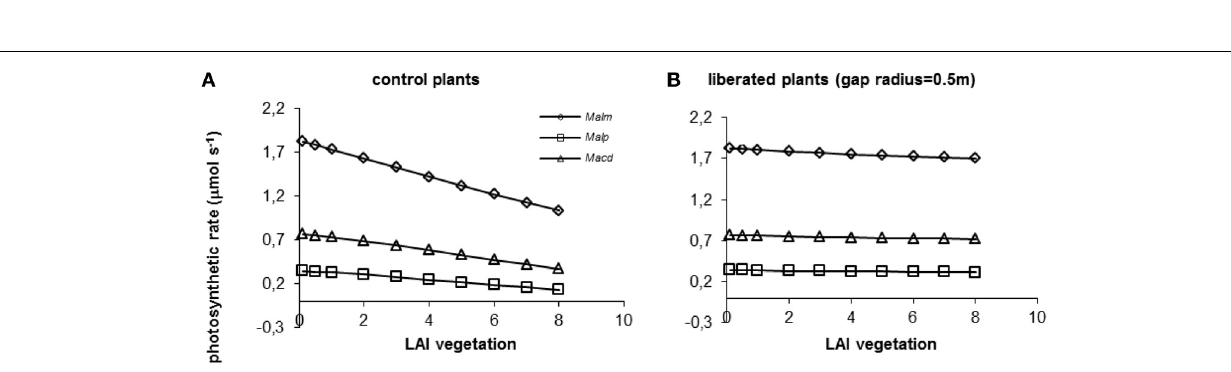
FIGURE 7 | (A,B) Model simulations of the effect of LAI of the surrounding vegetation on whole canopy photosynthetic rates of species in a control situation (surrounding vegetation intact) (A) and